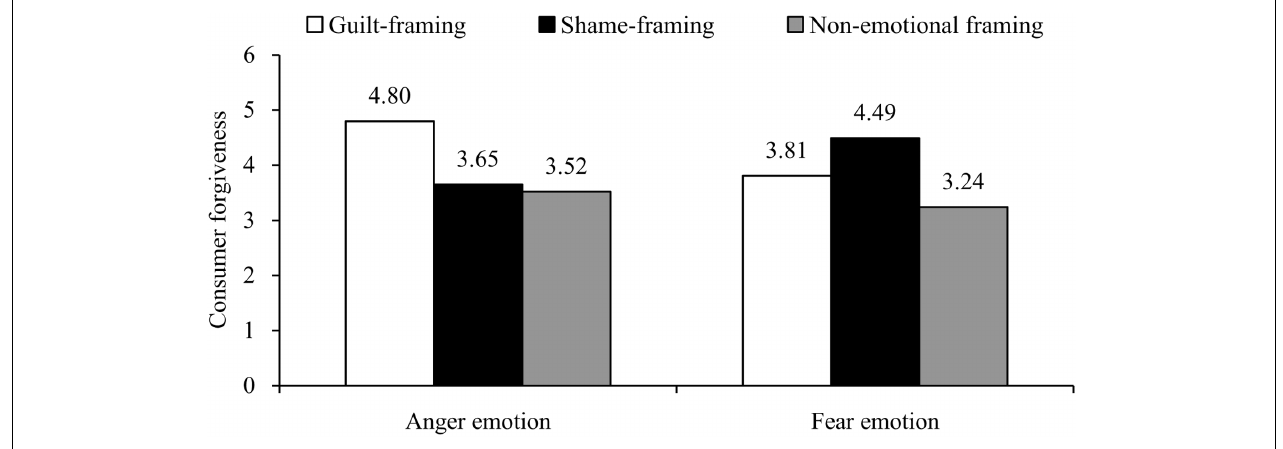
FIGURE 1 | Interaction effect of consumer emotion and company emotional frame on consumer forgiveness (Study